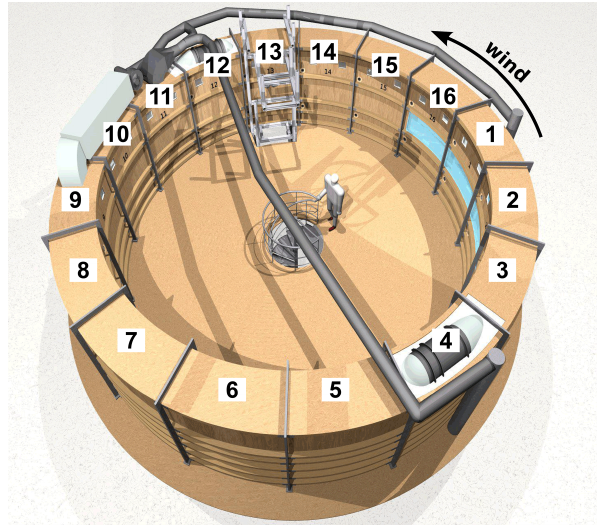
Figure 1. Rendered view of the Aeolotron, taken from Krall (2013). The 16 segments are numbered clockwise, while the wind direc- tion is counterclockwise. The wind generating fans can be seen in segments 4 and 12. The heat transfer velocity is measured in seg- ment 13, while the gas transfer measurements integrate over the whole water